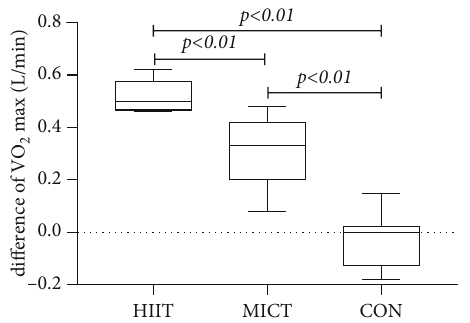
max in each group after 2